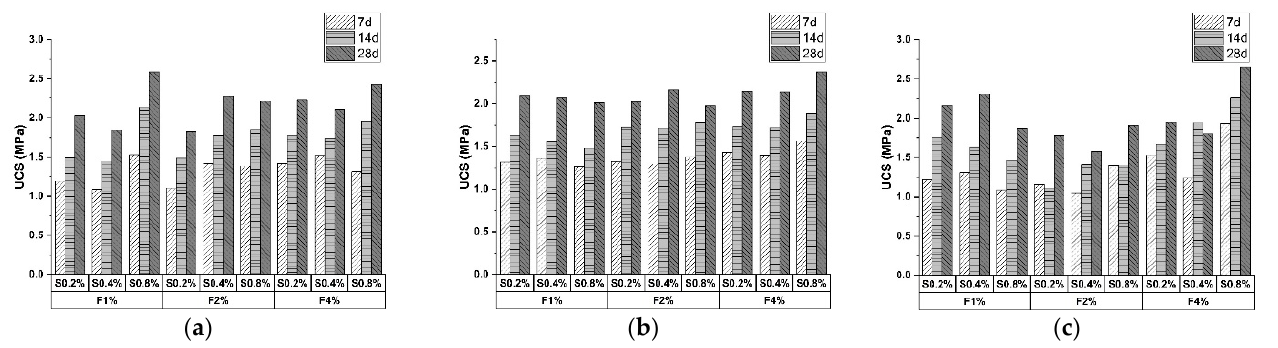
Figure 4. Unconfined compressive strength of 30% cement specimen with ( a ) 10% C&D waste; ( b ) 20% C&D waste; ( c ) 30% C&D waste (Note: S represents sodium sulfate; F represents polypropylene fiber).